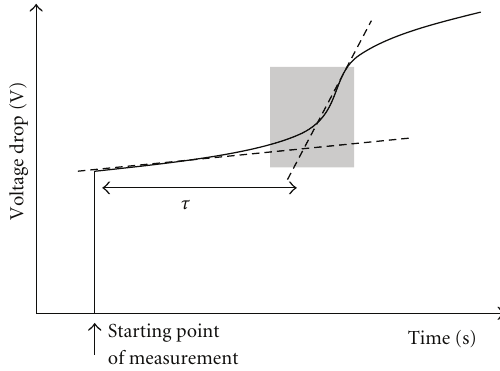
Figure 3: Schematic drawing of chronopotentiogram.